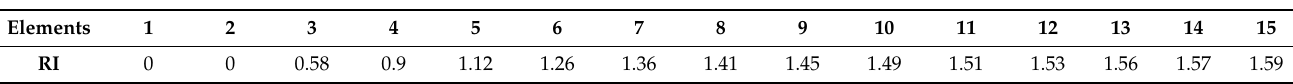
Table 3. The RI Values.